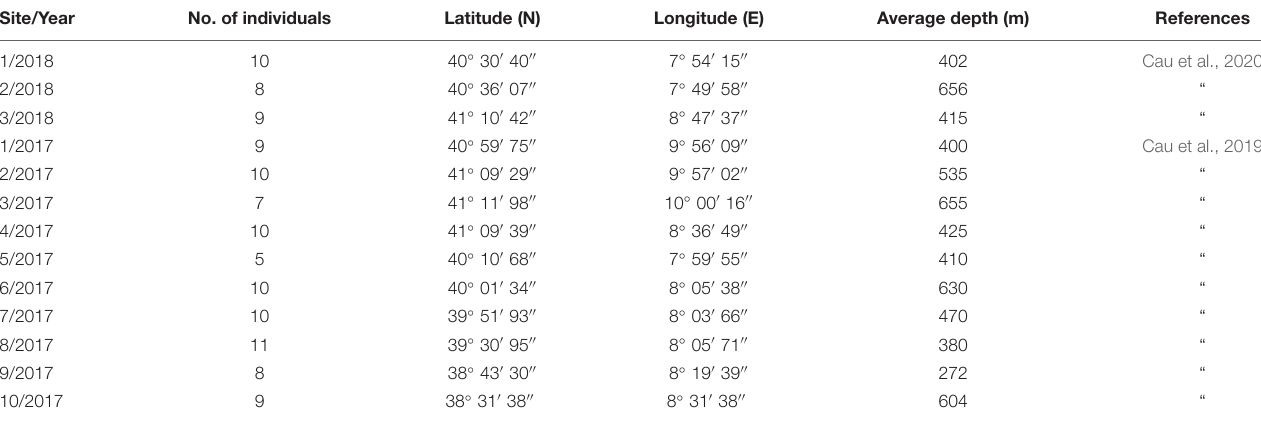
TABLE 1 | Sites ID and year of sampling; number of individuals of N. norvegicus collected, geographical coordinates and average depth of trawls. Site/Year No. of individuals Latitude (N) Longitude (E) Average depth